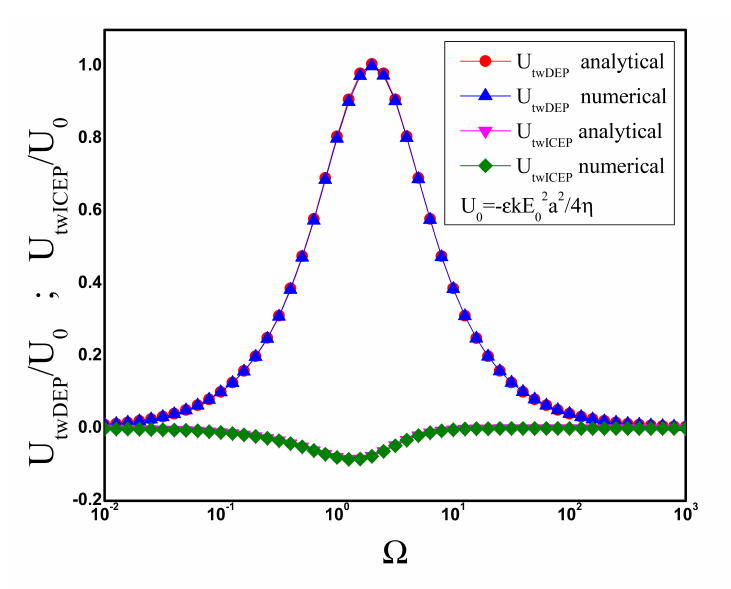
Figure 4. Travelling-wave dipolophoresis of a metal sphere as a function of angular frequency of the applied ac field. Analytical and numerical results are compared. The velocity is non-dimensionalized a 2 /4 η with U 0 = − ε kE 2 0